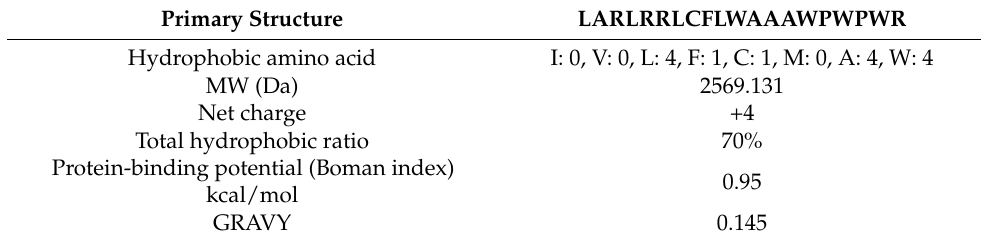
Figure 1. Bioinformatics analysis of the ZM-804 peptide. ( A ) Amino acids composition of the ZM-804 showing the highest percentage in hydrophobicity (diagram created by Origin ® ). ( B ) In the helical wheel diagram of the ZM-804 peptide, the positively charged residues are defined by blue color while the hydrophobic residues are defined by yellow and grey. The ZM-804 peptide showed confirmations of an amphipathic alpha-helix. ( C ) 3D structure of the ZM-804 predicted by the I-TASSER and visualized by the Chimera 1.14rc software. Table 1. Physicochemical properties of the ZM-804